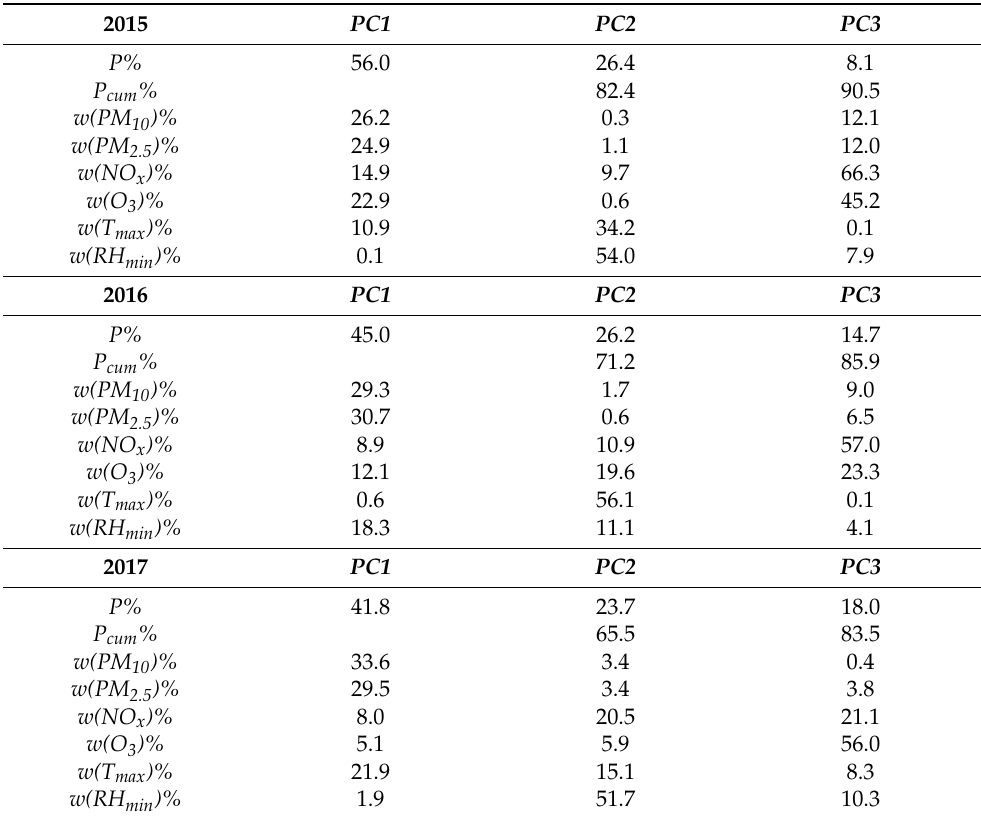
Table 6. PCA results for HDs detected in SS3 sampling site. In the upper part of the table, the percentage of explained variance ( P% ) and the cumulative percentage ( P cum % ) for the first three Principal Components ( PC ); in the lower part, the percentage weights ( w %) of the original descriptors in the new